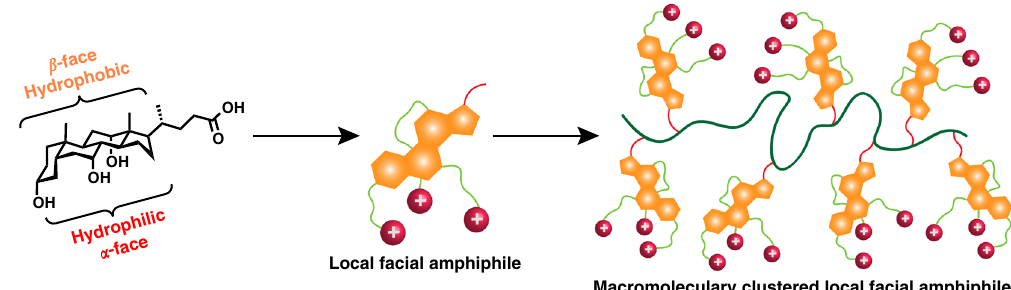
Fig. 2 Design principle of cationic polymers with an intrinsic facial amphiphilic structure at repeat units. The key building block should have a multicyclic structure with the possibility for derivatization to possess one face hydrophilic and the other face hydrophobic. Cholic acid is illustrated as an